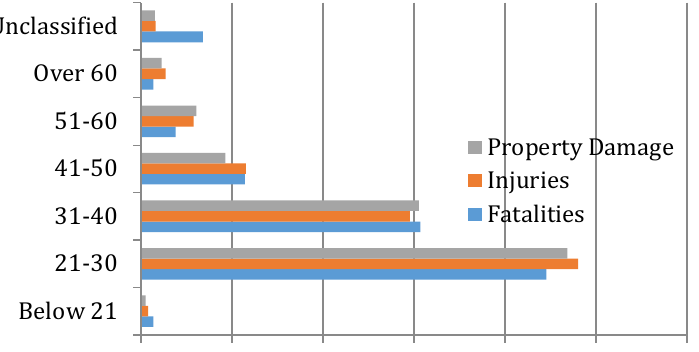
Figure 3: Heavy vehicle crashes distributions by drivers age